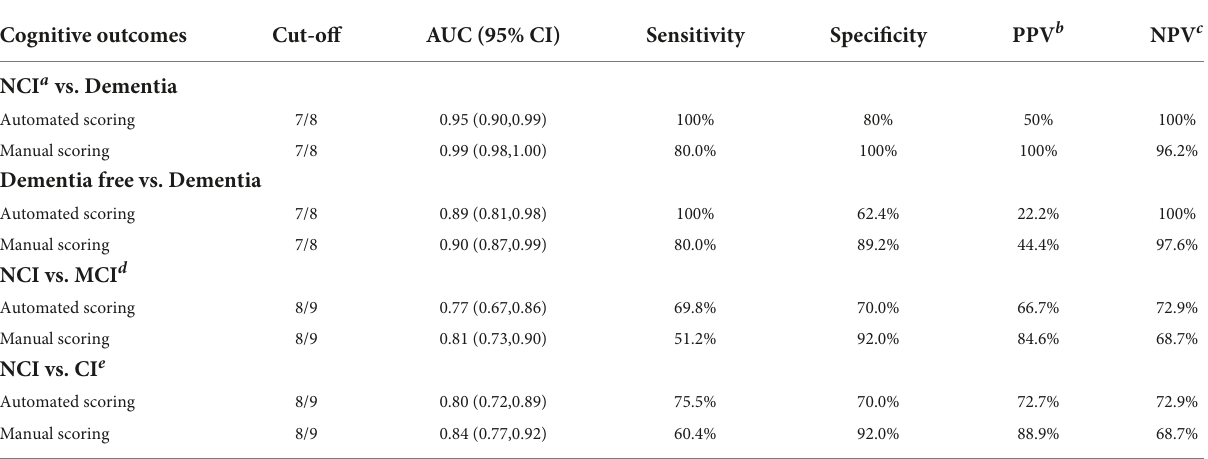
TABLE 2 Diagnostic ability of the DCS on different cognitive outcomes. Cognitive outcomes Cut-off AUC (95% CI) Sensitivity Specificity PPV b NPV